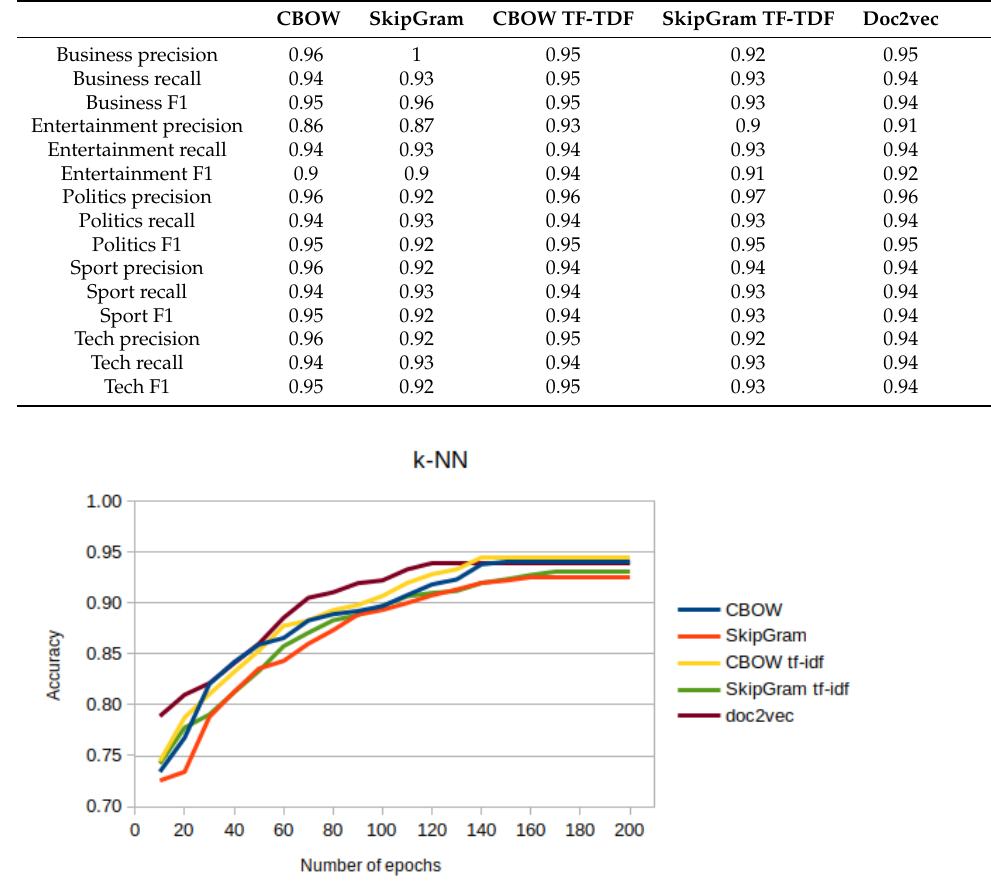
Figure 4. Accuracy of k-NN classification for selected text vectorization methods by